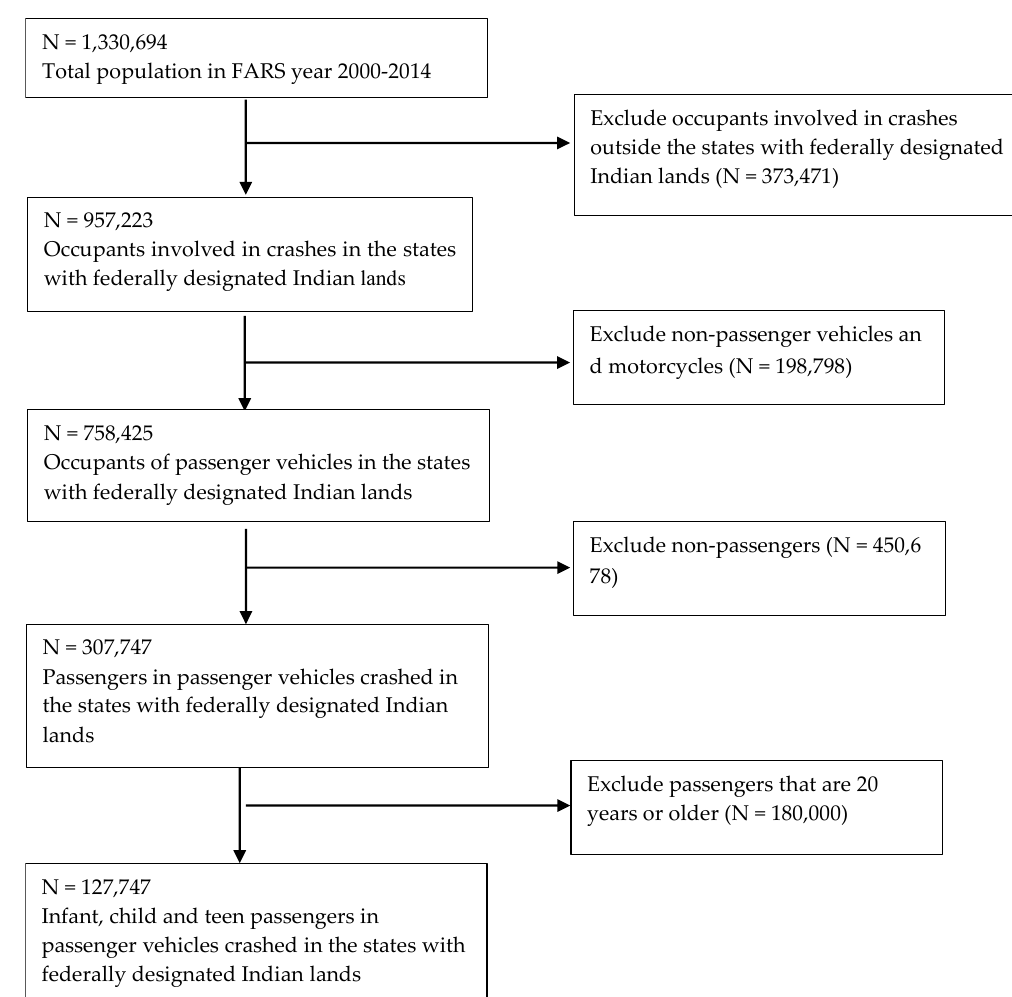
Figure 1. Population flow diagram of the study population of passengers aged 0–19 years, FARS 2000–2014.